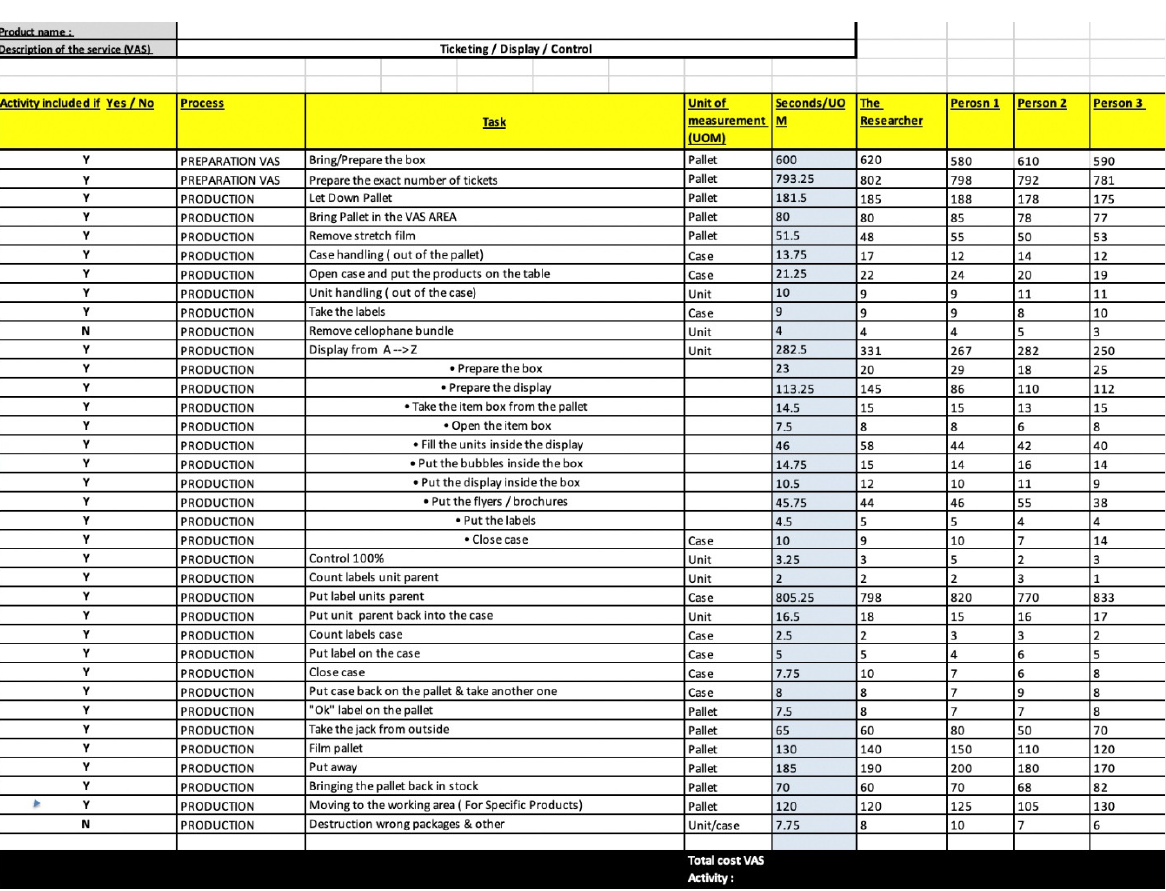
Figure 2. The general template for timing VAS activities. Note: display from A to Z (contains 10 sub processes, such as take the item box from the pallet, open the item box, fill the units inside the display, put the bubbles inside the box, etc.).